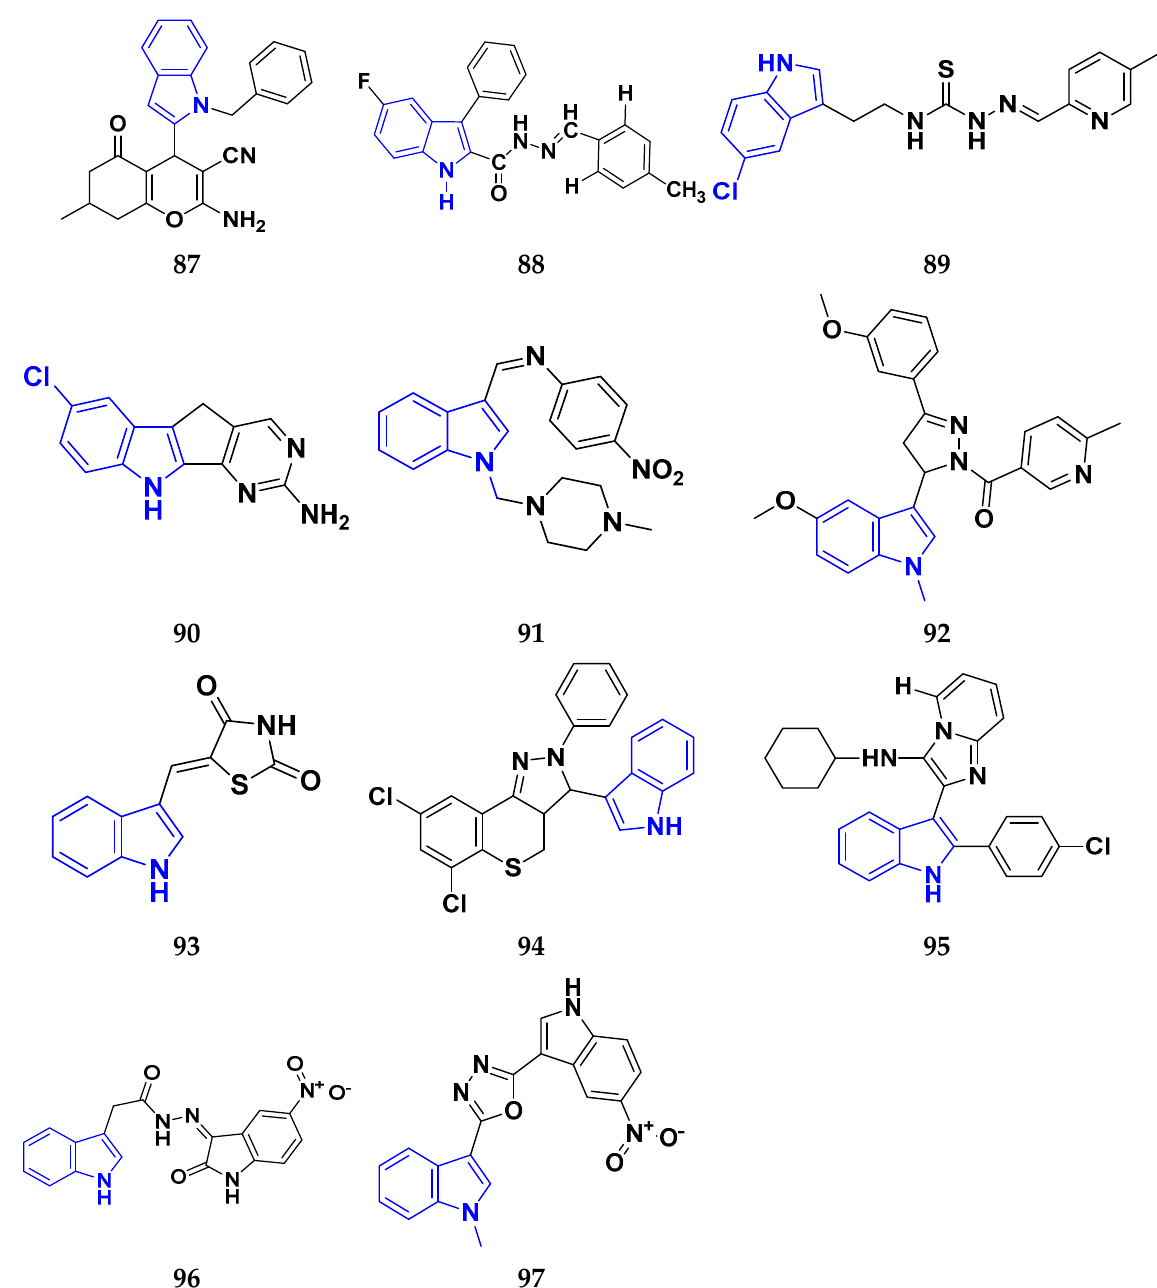
Figure 11. Indole derivatives ( 87 – 97 ) as anticancer agents.